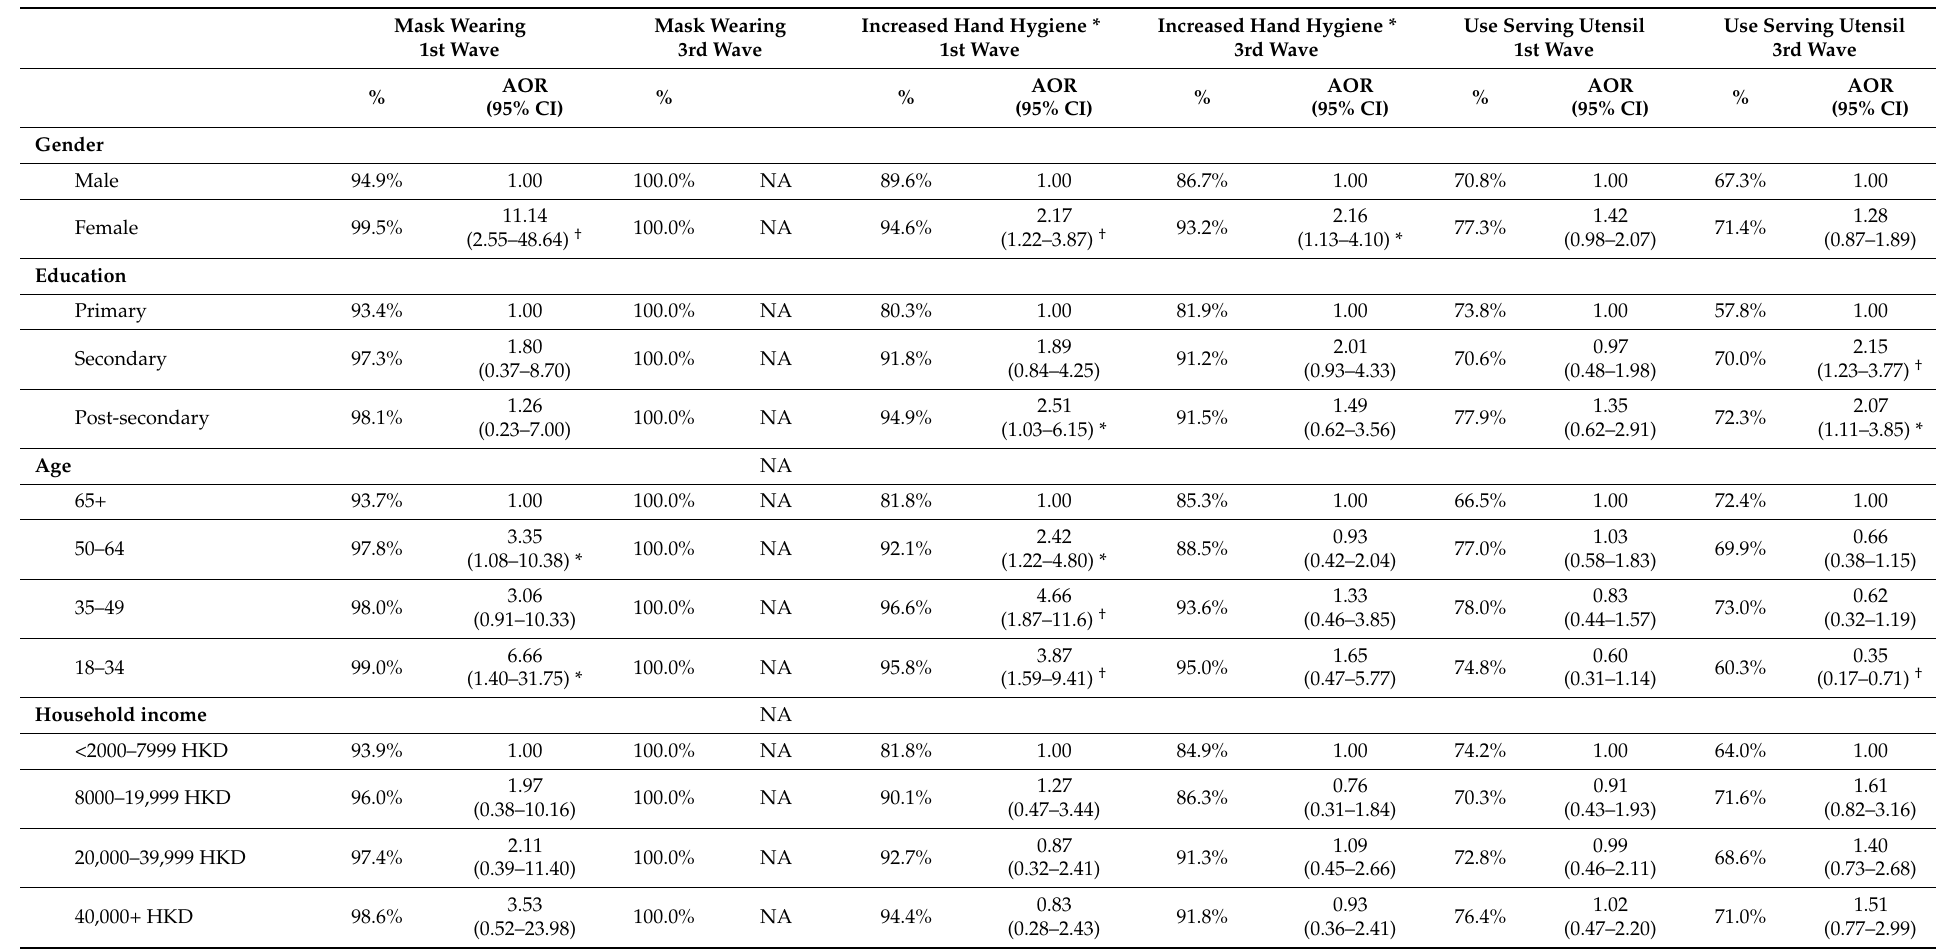
Table A1. Factors associated with compliance with personal hygiene measures in Hong Kong COVID-19 first wave and third wave. Mask Wearing 1st